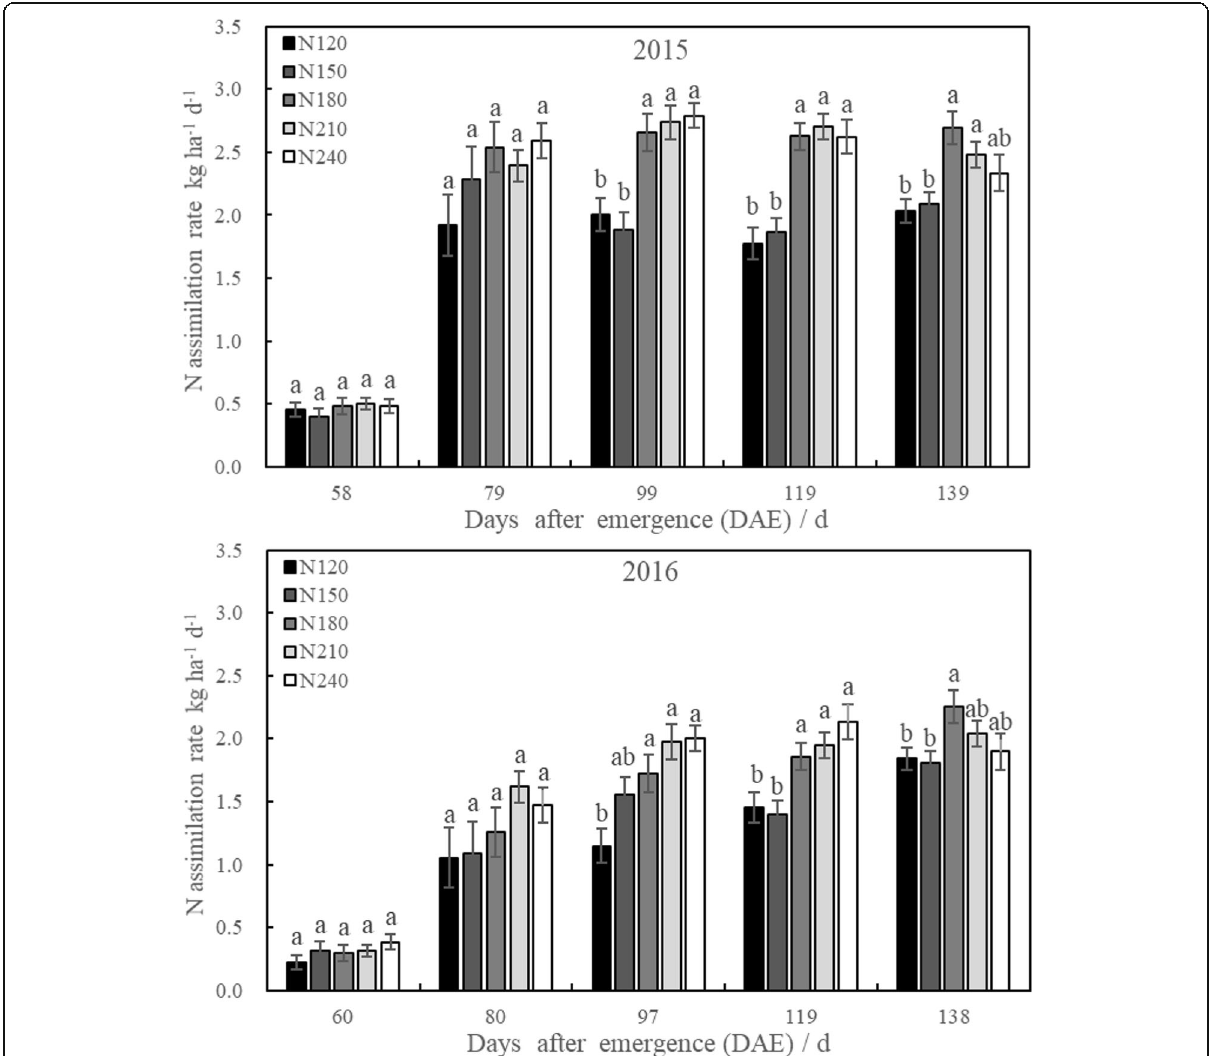
Fig. 2 Accumulation of N assimilation of the cotton plant at different stages varying the treatments during the 2015 and 2016 growing